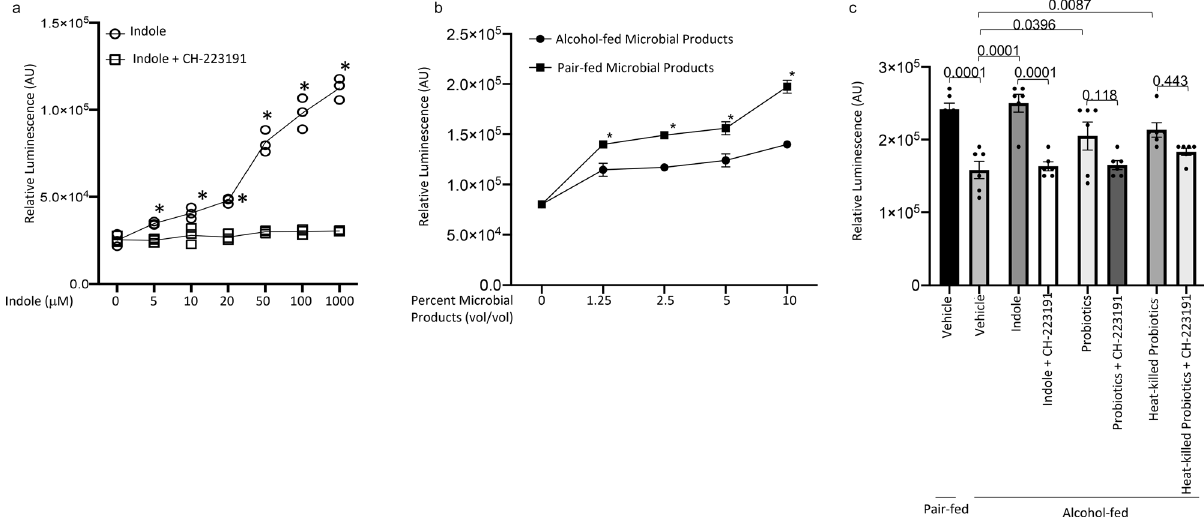
Fig. 8 Indole and intestinal microbial products from indole and probiotic treated mice increase AhR activation. a Dose – response curves of indole in the DR-EcoScreen assay. DR-EcoScreen cells were treated with increasing concentrations of indole, to detect AhR agonistic activity. b Dose – response curves of intestinal microbial products in the DR-EcoScreen assay. c Intestinal microbial products were isolated from binge-on-chronic alcohol-fed mice with and without treatment AhR agonistic activity was determined using the DR-EcoScreen assay. Bars represent the mean ± SEM and dots represent individual mice. P values are indicated in the fi gure and were determined by one ‐ way ANOVA with Sidak ’ s multiple comparison test. N = 5 –